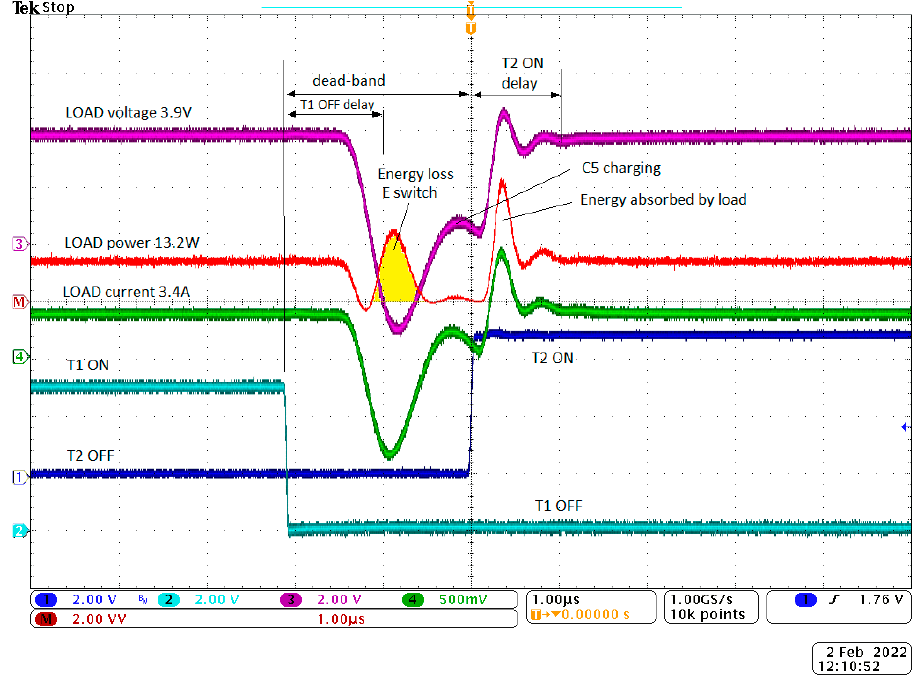
Figure 11. Measurement of the energy loss during switching. (Tektronix MSO4104 screen capture). Table 5 lists the energy loss values over the entire discharge curve for the A1-cell. The switching number (n) represents how many switching occurs during the total discharge time (t). Table 5. The energy loss during switching.